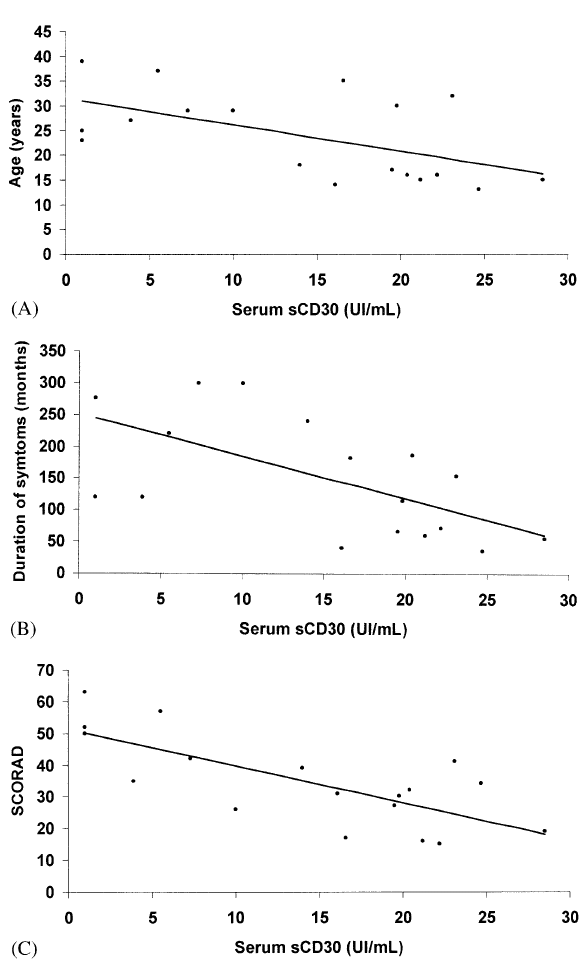
FIG. 1. (A) Correlation between serum sCD30 and age (years) (r (cid:3) / (cid:5) / 0.55; 95% CI for r(Fisher’s ztransformed) (cid:3) / (cid:5) / 0.81 to (cid:5) / 0.12; p (cid:3) / 0.01). (B) Correlation between serum sCD30 and duration of disease (months) (r (cid:3) / (cid:5) / 0.64; 95% CI for r (Fish- er’s ztransformed) (cid:3) / (cid:1) / 0.85 to (cid:5) / 0.24; p (cid:3) / 0.004). (C) Correla- tion between serum sCD30 and SCORAD (r (cid:3) / (cid:5) / 0.74; 95% CI for r(Fisher’s ztransformed) (cid:3) / (cid:1) / 0.89 to (cid:5) / 0.42; p (cid:3) /